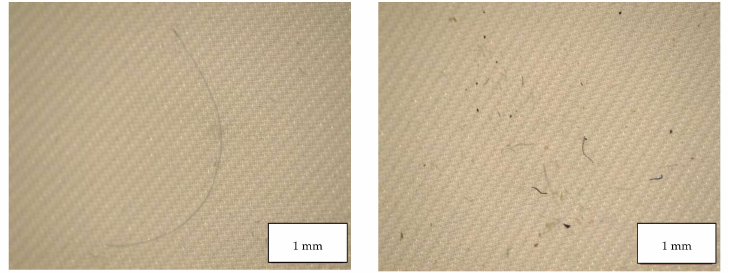
Figure 11. Microplastics detected in the filter of Surgical Mask Q seen at the stereomicroscope with scale bar of 1